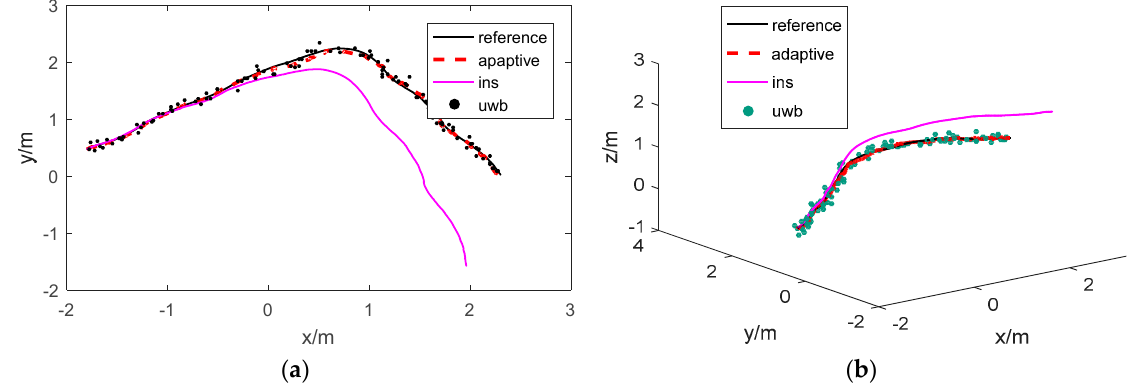
Figure 11. ( a ) Path tracking (x and y); ( b ) path tracking (x, y, and z).